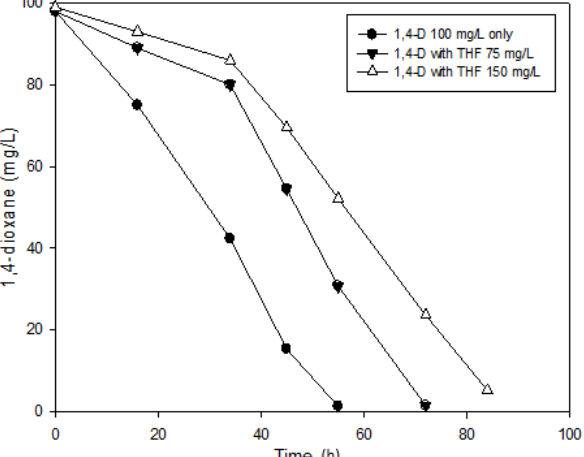
Figure 9. The biodegradation of 1,4-dioxane (1,4-D) in effect of different concentrations of tetrahydrofuran (THF).